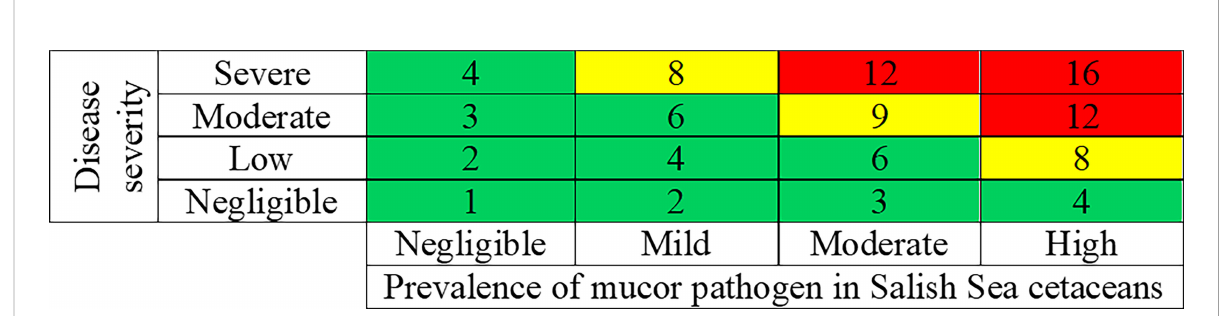
FIGURE 3 Risk matrix for combining the results of the disease severity scores (from Table 3) and the exposure scores (from Table 3), resulting in overall risk characterizations scores for mucormycosis in harbor porpoise. Green, yellow and red, respectively, represent negligible to low (combined together), moderate, and high